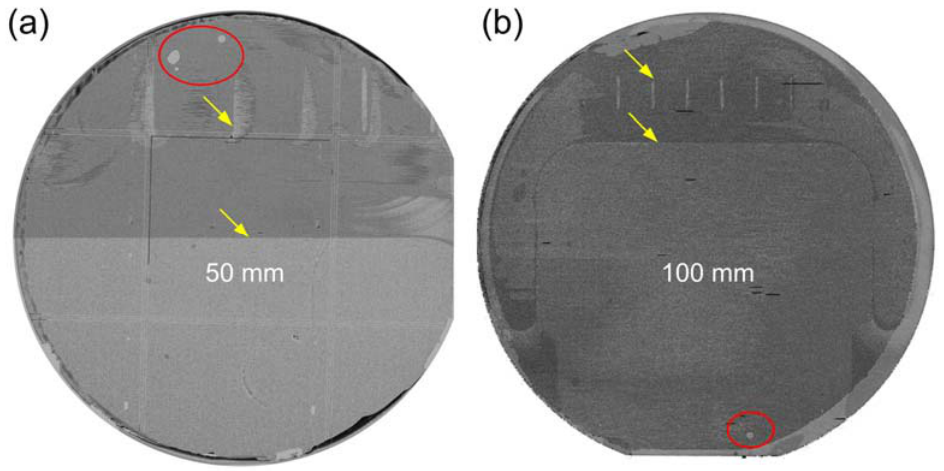
Figure 3. SAM images of (a) 50 mm and (b) 100 mm InP-to-Si bonded wafers. Interfacial voids are highlighted in red circles and yellow arrows indicate the horizontal (vertical in the image) scan lines and a pattern from the wafer chuck related to the